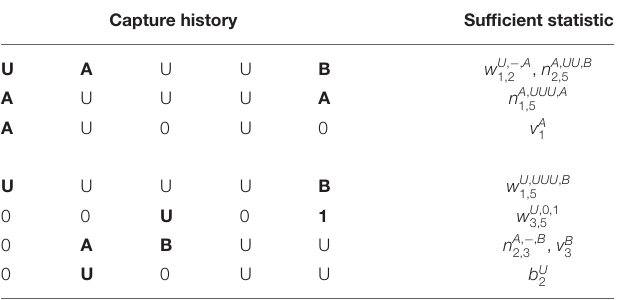
TABLE 1 | Illustrating how example individual capture histories contribute to the sufficient statistic terms, for a capture-recapture experiment with two observable states A, B, and five sampling occasions.